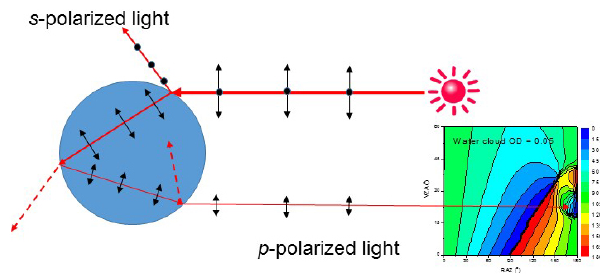
Figure 4. Illustration of the physics for the near-backscatter p - polarization feature of the reflected light from